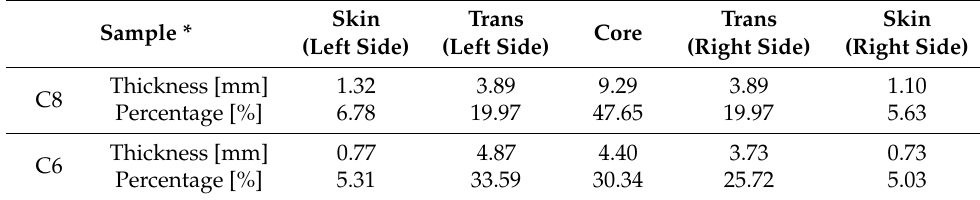
Figure 9. Scanning electron microscopy pictures taken from different regions of measurement parts of 8 mm ( a ) and 6 mm ( b ) thick molded pieces. SEM pictures on left (red frame) present a sample edge with the assumed border of a skin layer marked with a dashed line. The white arrow indicates the first observed pore, suggesting the end of a skin layer. Pictures in the middle (blue frame) present the transition layer while pictures on the right (black frame) show sample core. Table 4. Thickness (in mm) of a skin transition and core layer together with its percentage in a total sample’s thickness based on SEM images after scanning sample cross-section from left to right sample